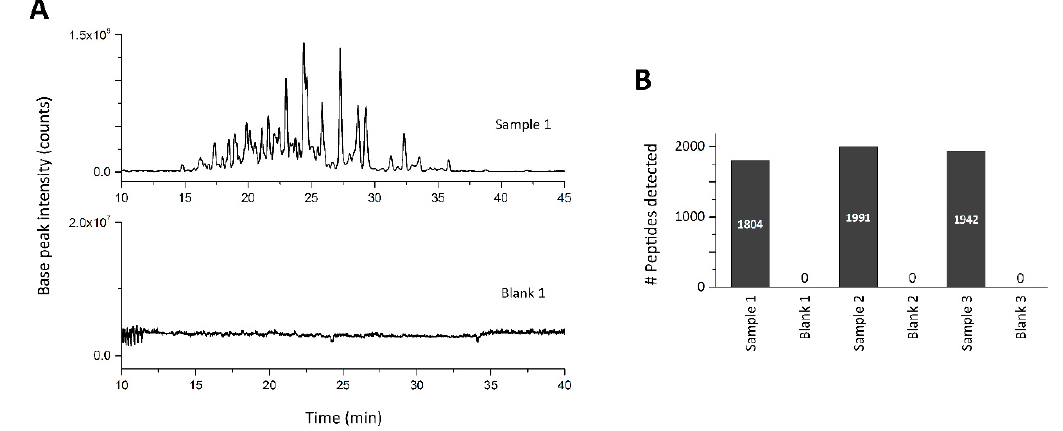
Figure 3. Carryover analysis of CESI-MS when analyzing a digested SiO 2 NM protein corona followed by a water blank. ( A ) Base peak electropherograms of SiO 2 NM protein corona above base peak electropherogram of subsequent blank injection. ( B ) Peptides identified in each sample injection and subsequent blank.